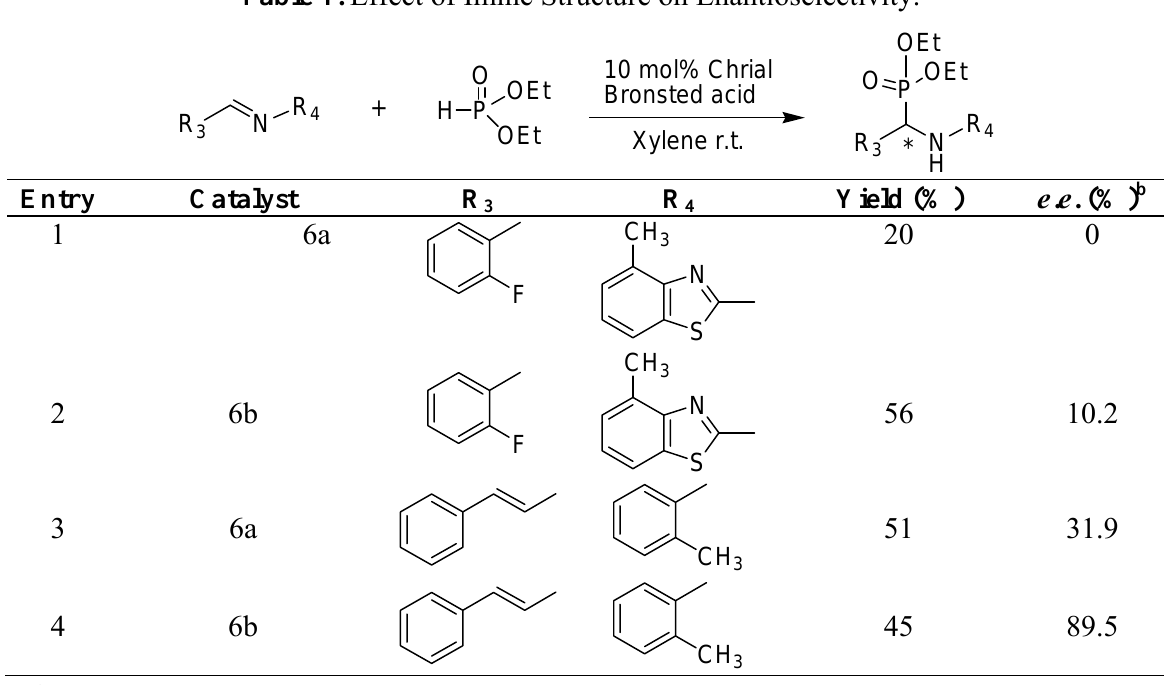
Table 1. Effect of Imine Structure on Enantioselectivity.